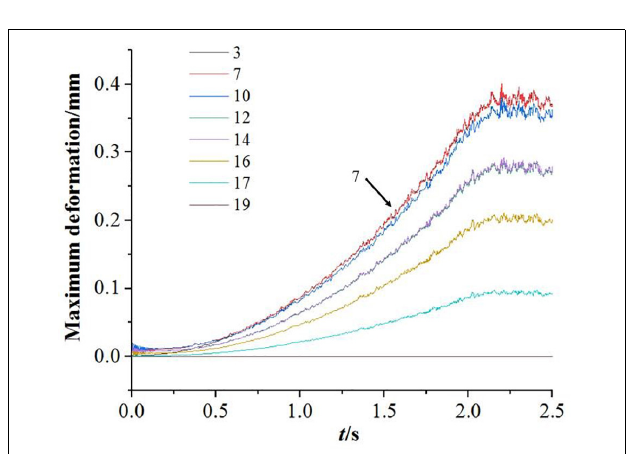
FIGURE 7 | The maximum deformation varies with time.